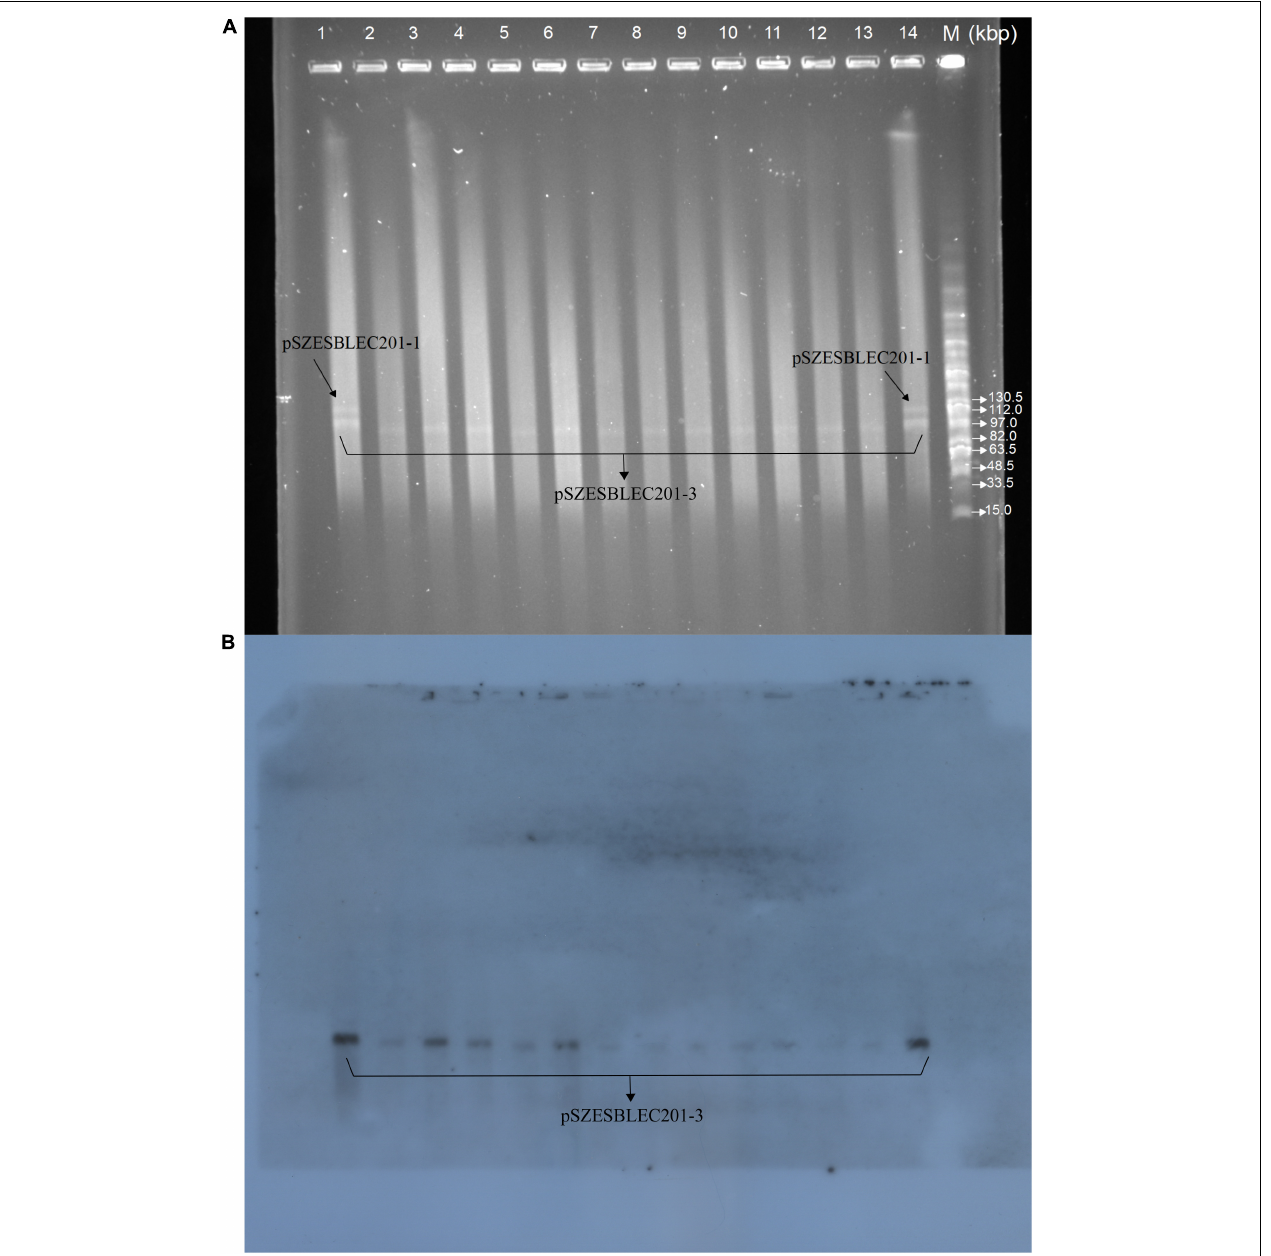
FIGURE 1 | S1-PFGE plasmid pattern and Southern blot for strain SZESBLEC201 and transconjugant TcJ53-CTX-M. (A) PFGE result for S1-digested plasmids of strain SZESBLEC201. Lanes 1 and 14: plasmid profile of strain SZESBLEC201, Lanes 2–13: plasmid profile of transconjugant TcJ53-CTX-M. Lane M: New England Biolabs MidRange PFG marker. (B) Southern blot hybridization with probe specific to bla CTX - M Group